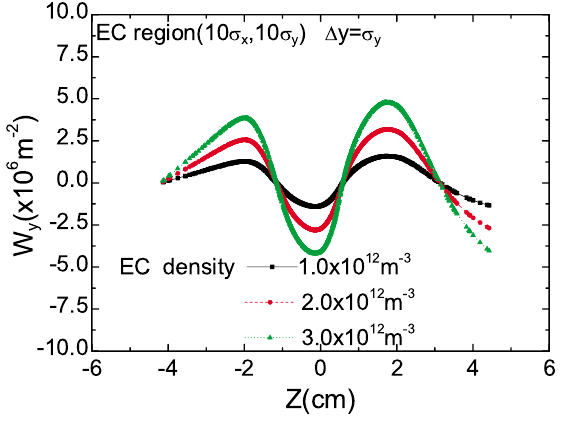
FIG. 15. (Color) Short-range wake due to EC.FIG. 14. (Color) EC density versus width of the